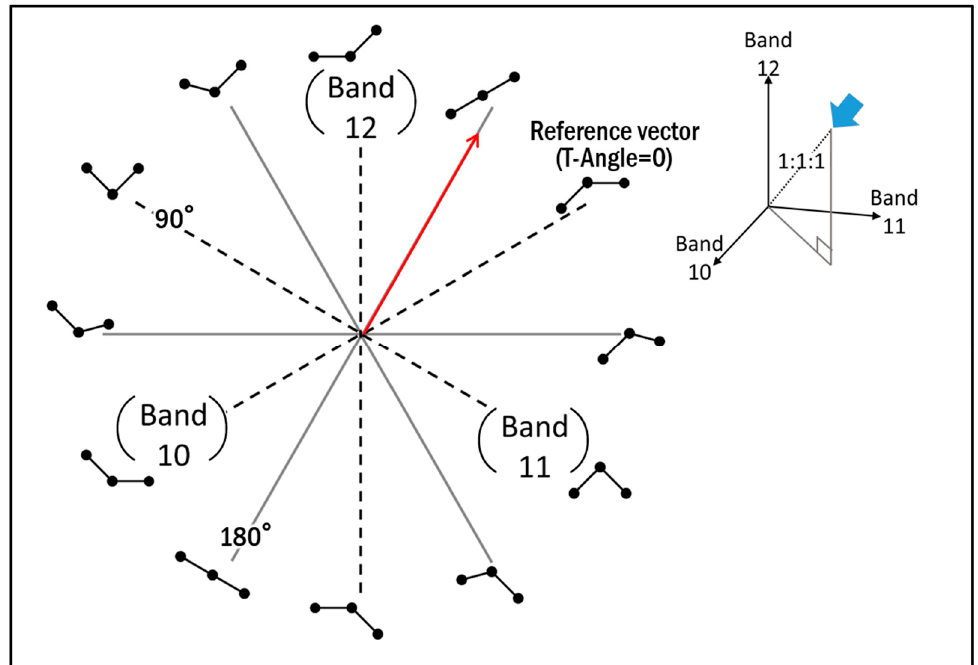
Figure 2. Concept of orthogonal transformation in the three-dimensional space of the reflectance of ASTER bands 10, 11, and 12.